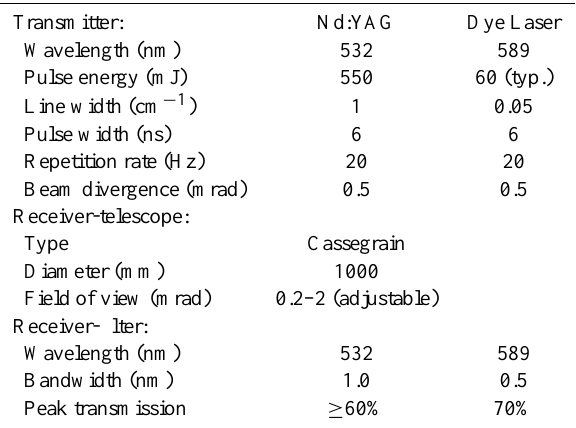
Table 1. Main specifications of USTC lidar